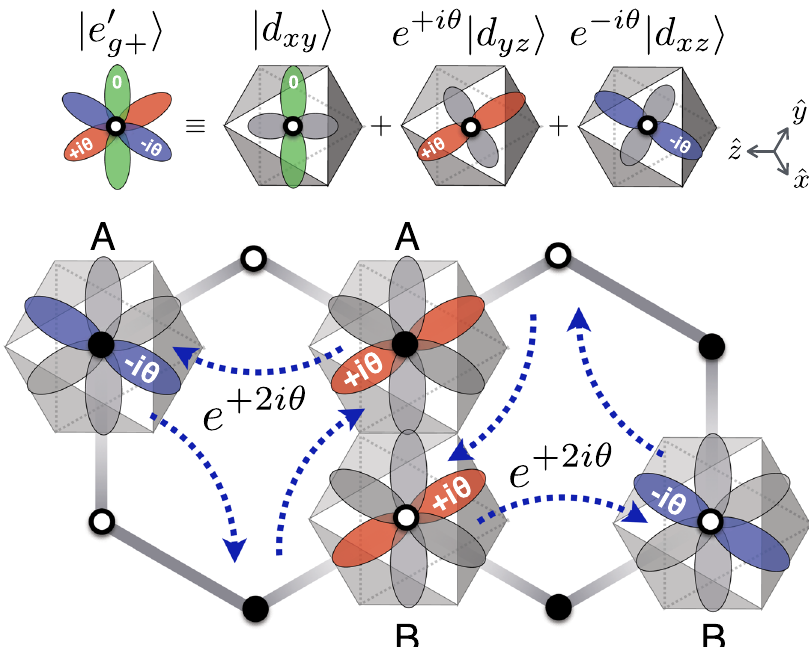
Fig. 2 Illustration of a orbital at Fe site and depiction of next-nearest-neighbor (n.n.n.) complex hopping terms between the e ′ g ± orbitals. In the hopping fi gure, dxz , yz orbitals, which contribute most to the horizontal n.n.n. hopping, are colored within each e ′ g ± state. Note that, the n. n.n. hopping channels represented as dashed blue arrows can be transformed to each other by the inversion at the n.n. bond center and the threefold rotation symmetries (color